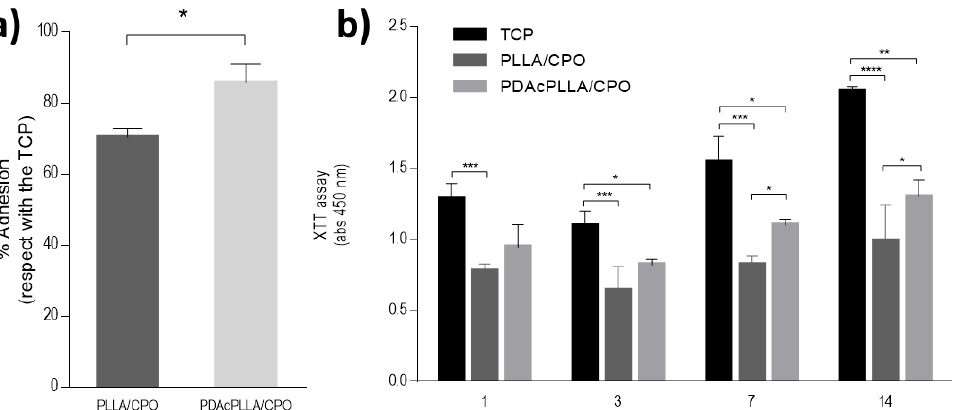
Figure 9. In vitro evaluation of PLLA/CPO and PDA-coated PLLA/CPO aerogels. ( a ) Cell adhesion after 24 h. Results show the percentage of adhesion with respect to the control (TCP). ( b ) Cell proliferation after 1, 3, 7, 14 days. (* p < 0.05; ** p < 0.01; *** p < 0.001; **** p < 0.0001).